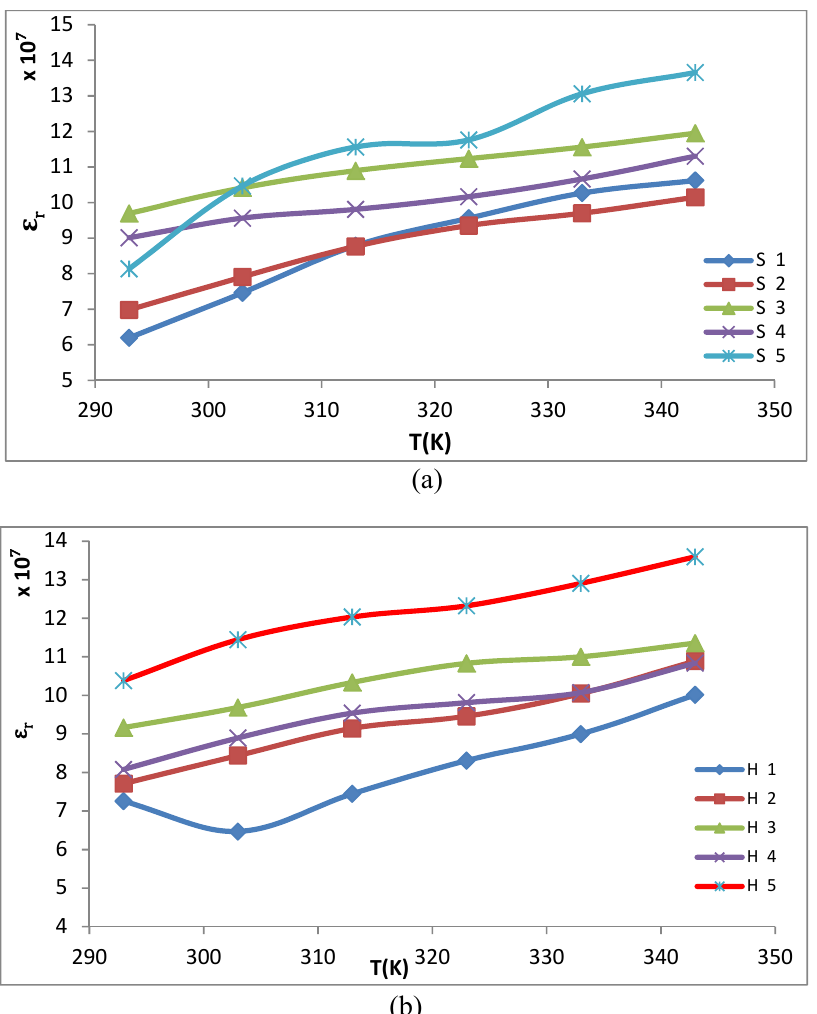
Fig. 4: Dielectric constant vs. Temperature with different salts weight ratio for electrolytes (a) S and (b)